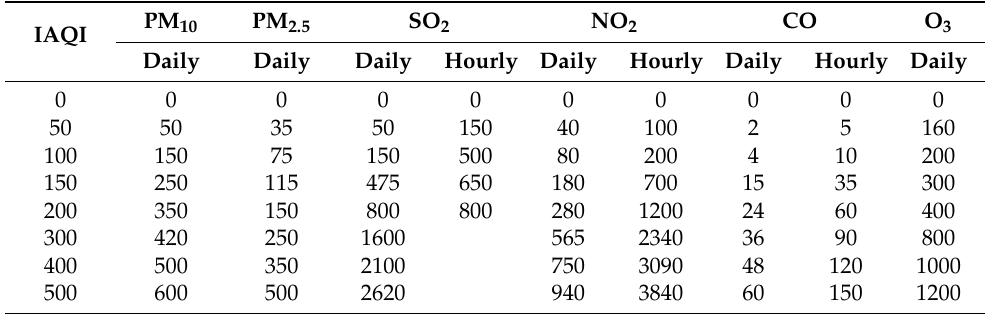
Table 1. IAQI and the correspondingly limited concentrations of each pollutant (PM 2.5 , PM 10 , CO, SO 2 , NO 2 and O 3